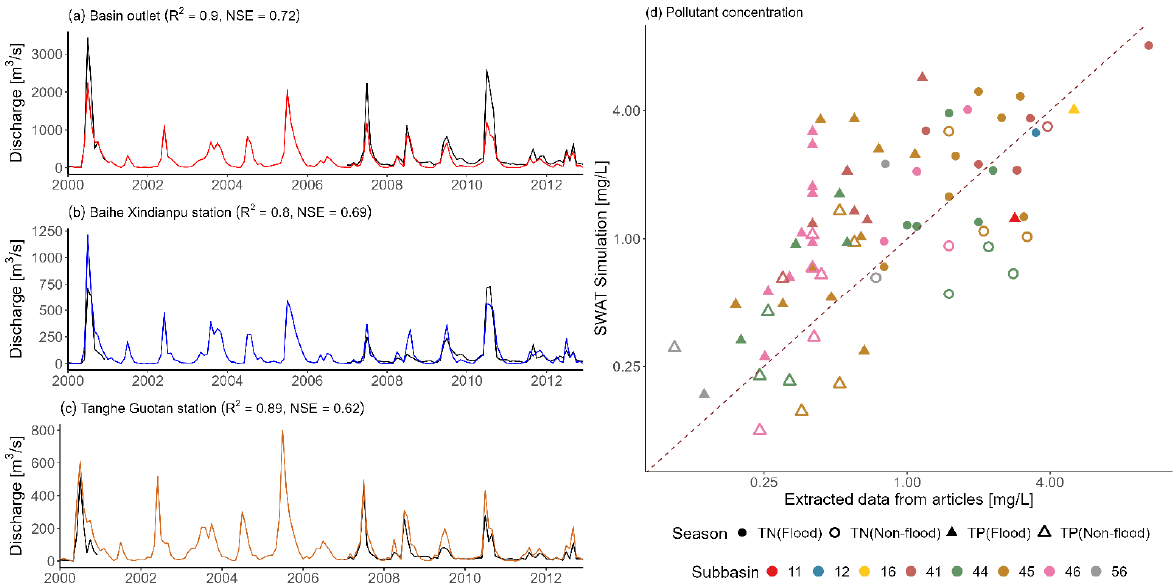
Figure 3. Comparison between SWAT simulation and record extracted from articles with respect to monthly streamflow ( a – c ) and TN and TP concentrations (mg/L) ( d ). The flood season refers to the months of April to September, and the non ‐ flood season refers to the remaining months. The distribution of the subbasin index is found in the following Figure 4.